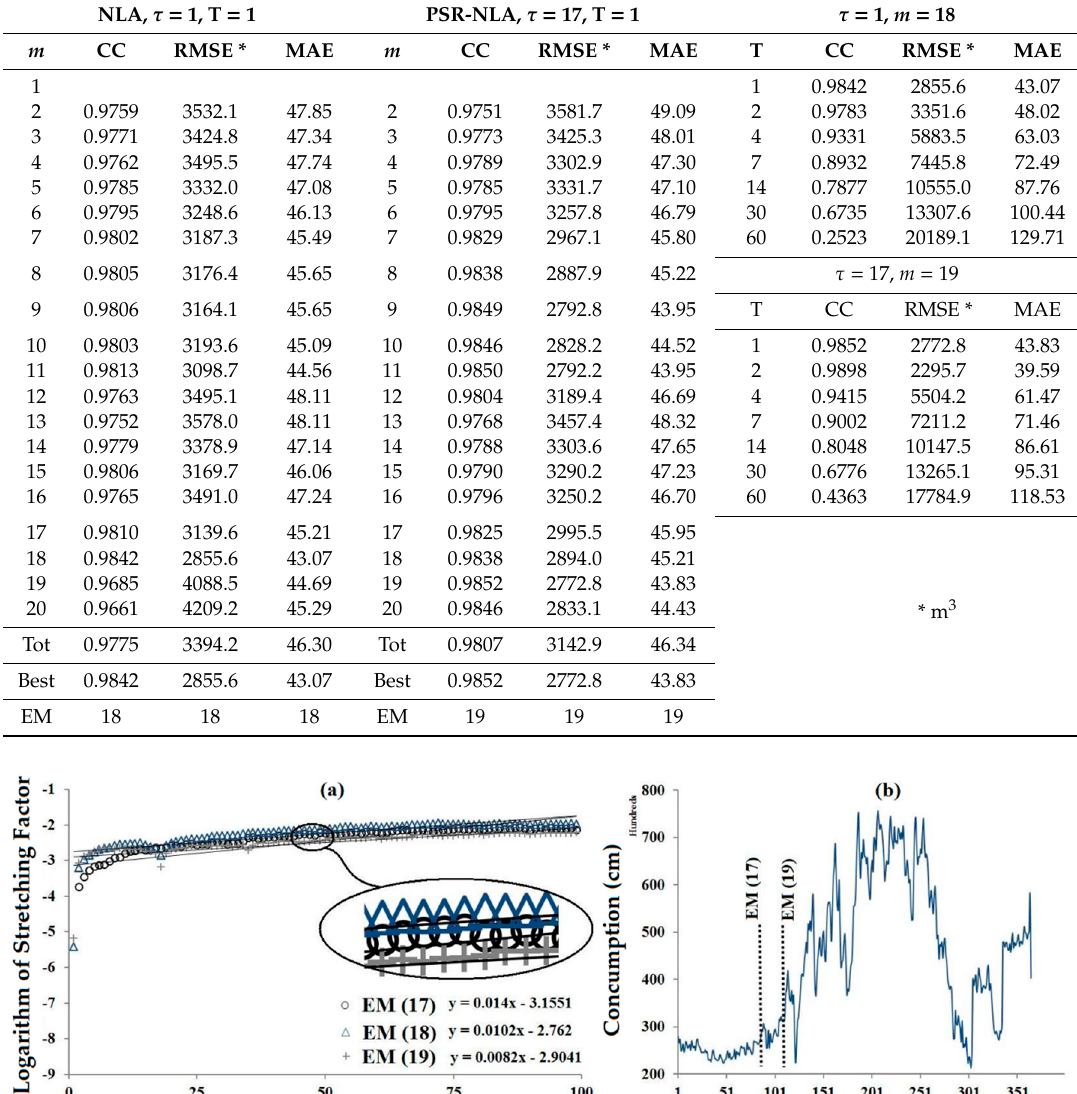
Table 3. Fitness values for NLA and PSR-NLA methods in di ff erent embedding dimension lag time and lead time.